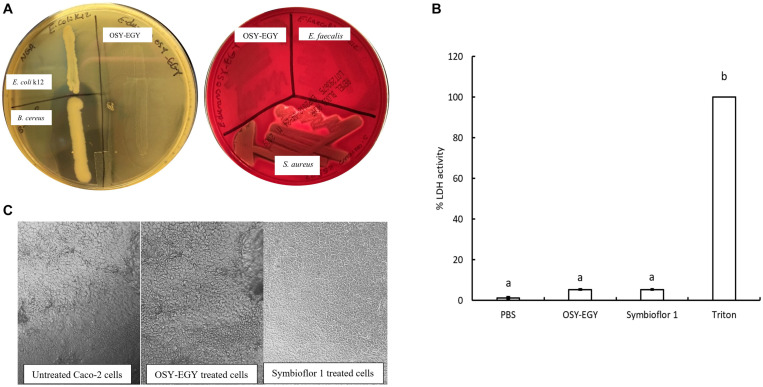
Safety traits of Enterococcus durans OSY-EGY. (A) Gelatinase activity (Left panel) of E. durans OSY-EGY compared to Bacillus cereus ATCC 14579 (positive control) and Escherichia coli k12 (negative control) on nutrient agar containing 3% gelatin and flooded with ammonium sulfate saturated solution. Clear zone indicates gelatin hydrolysis due to gelatinase production. Hemolytic activities (right panel) of E. durans OSY-EGY on blood agar compared to S. aureus ATCC 25923 as positive control and E. faecalis ATCC 29212 as negative control. Clear zone indicates red blood cells lysis due to hemolysin production. (B) Cytotoxic effect of E. durans OSY-EGY or E. Faecalis (Symbioflor 1) strains on Caco-2 cells after 24 h treatments. Values were expressed as means ± SD of two independent repeats. Treatments that were significantly different at P ≤ 0.05 were indicated by different letters. (C) Microscopy observation of Caco-2 cells after 3 h of treatment with E. durans OSY-EGY or E. faecalis Symbioflor 1 compared to untreated Caco-2 cells.